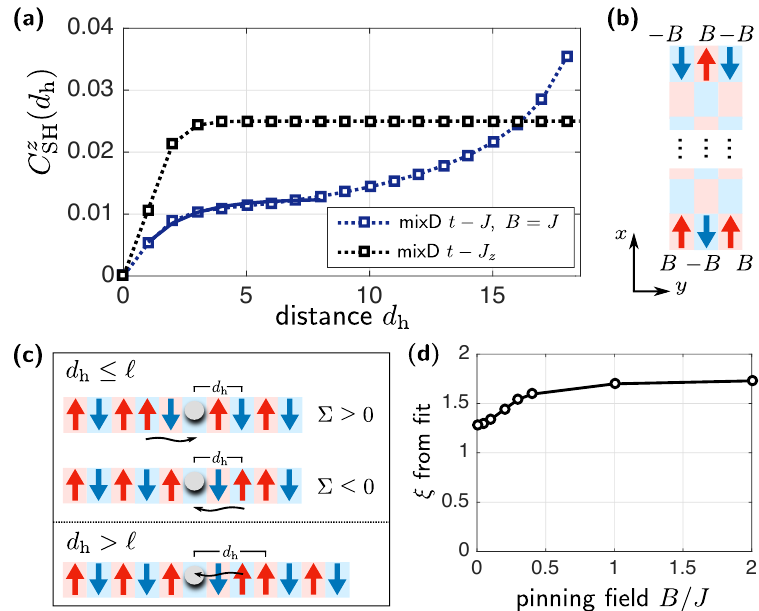
Figure 3: Distortion of the Néel state by mesons. We calculate spin-hole cor- ( d ) , calculated using DMRG in relations for t = 3 J . (a) The two-point function C z h SH = L / 2, shows a pronounced a 40 × 3 system with open boundary conditions for j x 0 dip at small d . This is an indicator for meson formation, as can be understood by h considering a hole moving in a classical Néel state (mixD t − J model): (c) When the z string length (cid:96) = | Σ | ≥ d , configurations with positive and negative strings, Σ < 0 h and Σ > 0, cancel each other. When (cid:96) < d both configurations contribute with the h same sign. The DMRG data in (a) includes a staggered magnetic field B at the edges, as shown in (b), which pins the AFM order in the three-leg system. (d) The charac- ( d ) at short distances changes only weakly when teristic length ξ of the dip in C z h SH the staggered field is